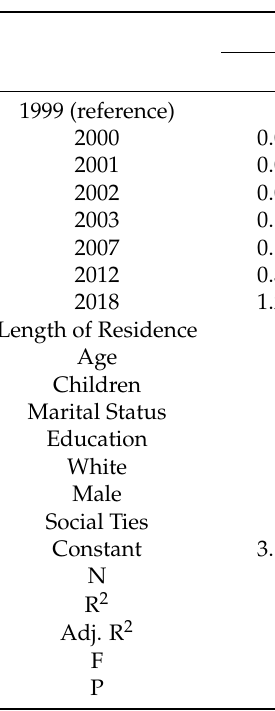
Table 2. Change in Community Attachment Over